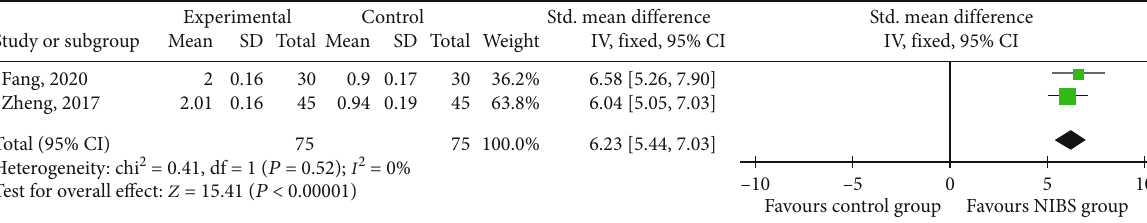
Figure 6: E ff ects of NIBS on FDS scores of patients with dysphagia after stroke. Experimental Control Std. mean difference Study or subgroup